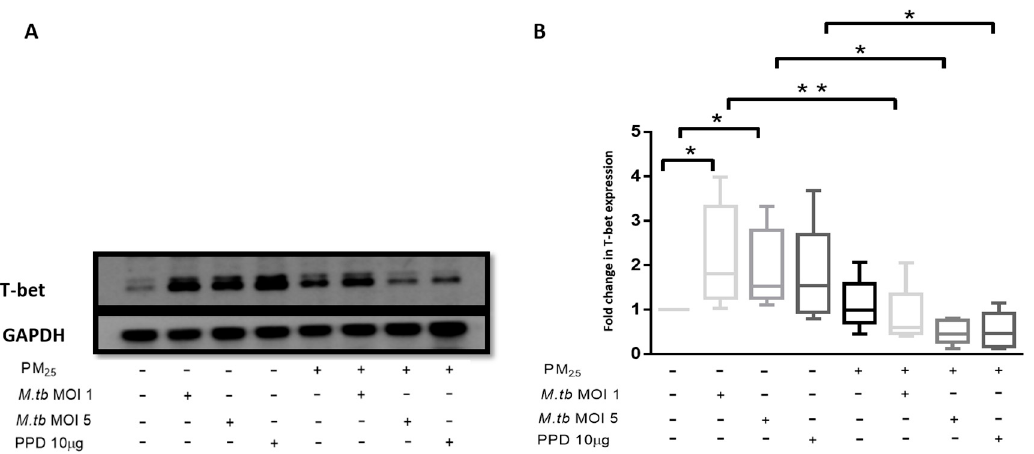
Figure 7. PM 2.5 exposure decreases T-bet expression in PBMC. ( A ) Representative western blot results showing the e ff ects of PM 2.5 -exposure on the expression of T-bet. PBMC were pre-exposed to PM 2.5 (5 µ g / mL) for 20 h followed by infection with M.tb MOI 1 or MOI 5 or stimulation with PPD (10 µ g / mL) for 18 h. PBMC were then lysed, cellular protein extracts prepared and resolved by SDS-PAGE, and western blotting performed with specific antibodies for T-bet and GAPDH (housekeeping gene). ( B ) Densitometric results of five independent experiments were obtained and normalized for GAPDH. Data represent fold change in T-bet expression expressed as 5 / 95 percentile box-and-whiskers where the center represents the 50th percentile, the upper hinge the 75th percentile, and the lower hinge the 25th percentile. Statistically significant increases between T-bet expression levels of uninfected and M.tb-infected PBMC are shown with single ( p < 0.05) while statistically significant decreases in T-bet expression levels between M.tb-infected and PM 2.5 -exposed / M.tb-infected PBMC are shown with single ( p < 0.05) and double ( p < 0.01) asterisks.